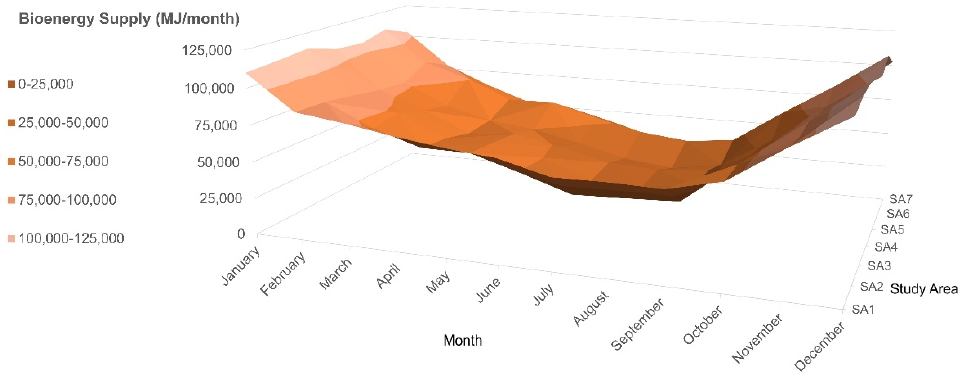
Figure 7. Bioenergy supply in the hybrid-modular system per month by sector.